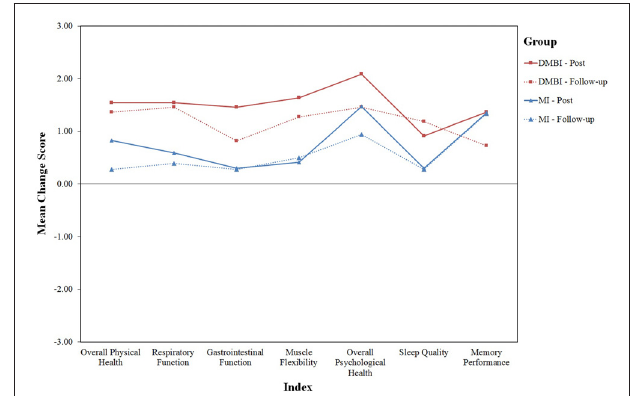
FIGURE 1 | Percentage changes in the 10-min delayed recall on the Hong Kong List Learning Test (HKLLT) from baseline to post-intervention assessment (Post) and follow-up assessment (Follow-up) in the Dejian Mind-body Intervention (DMBI; n = 10) and Memory Intervention (MI; n = 16) groups. One participant from the DMBI group and two participants from the MI group were excluded because they were identified as extreme outliers by boxplots.